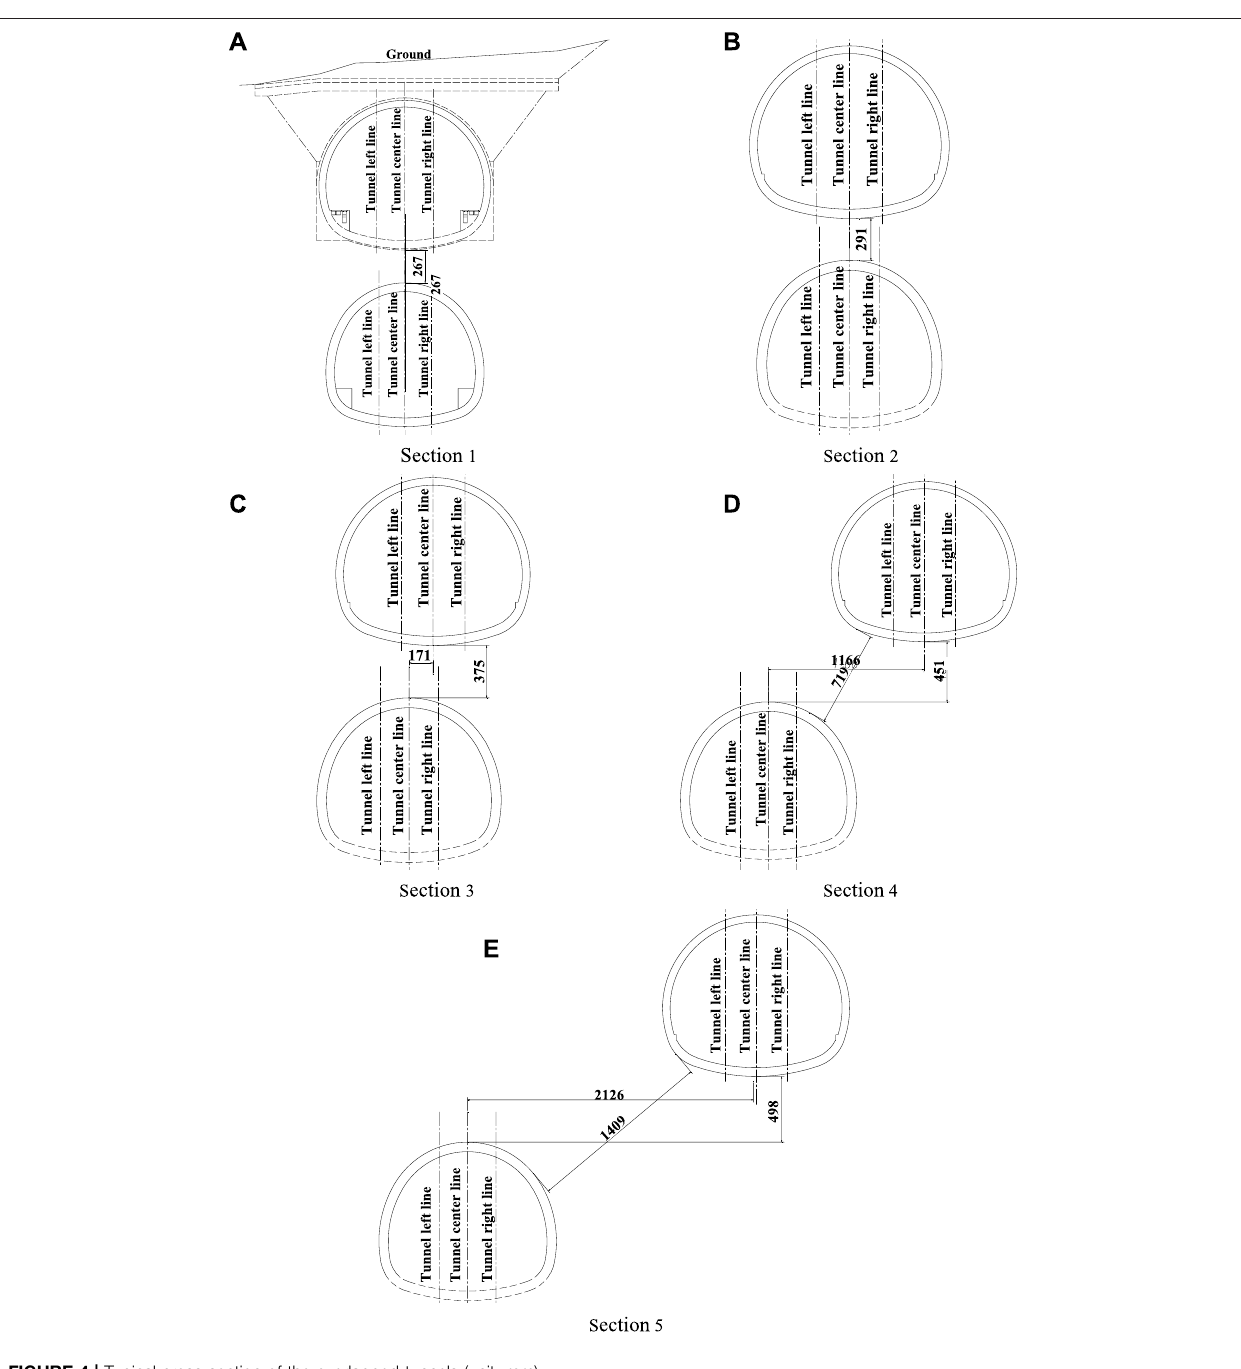
FIGURE 4 | Typical cross section of the overlapped tunnels (unit: